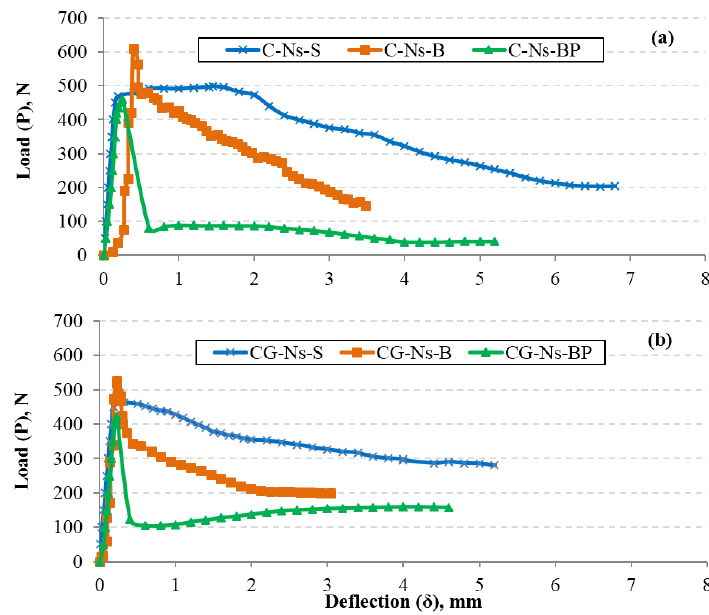
Figure 1. Load-deflation ( P- δ) curves of the NFRM reinforced with different fibers: ( a ) OPC; and ( b ) OPC/GGBS.